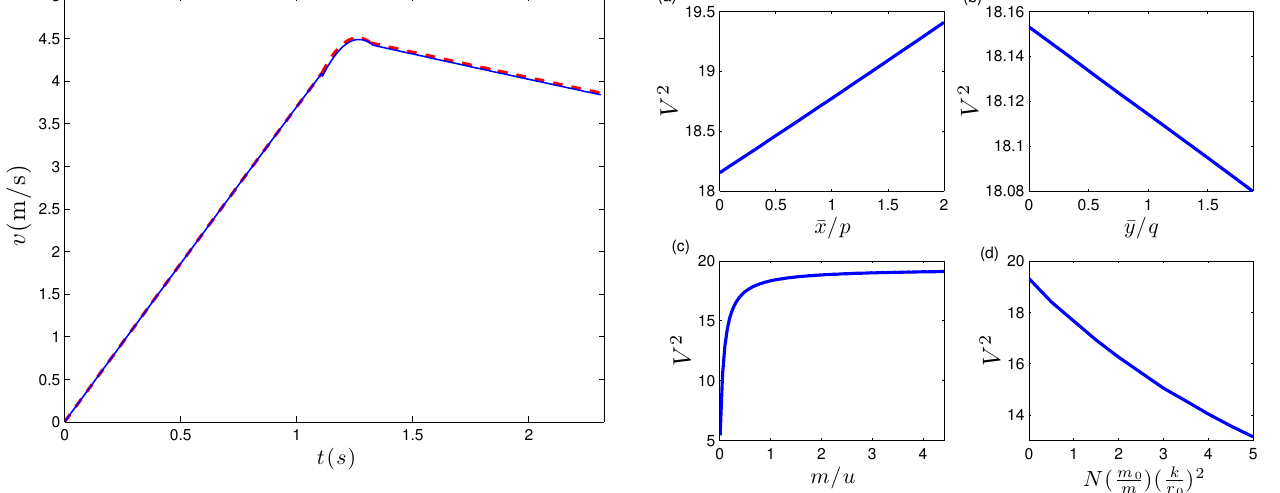
Figure 5. Theoretical trends in v 2 with the dissipative forces in- cluded; results show the e ff ects of varying ¯ x (a) , ¯ y (b) , m (c) , and the wheel parameters (d) with parameters given in Table 2 and the nor- malization constants p = 0 . 09m, q = 0 . 013m, and u = 0 .